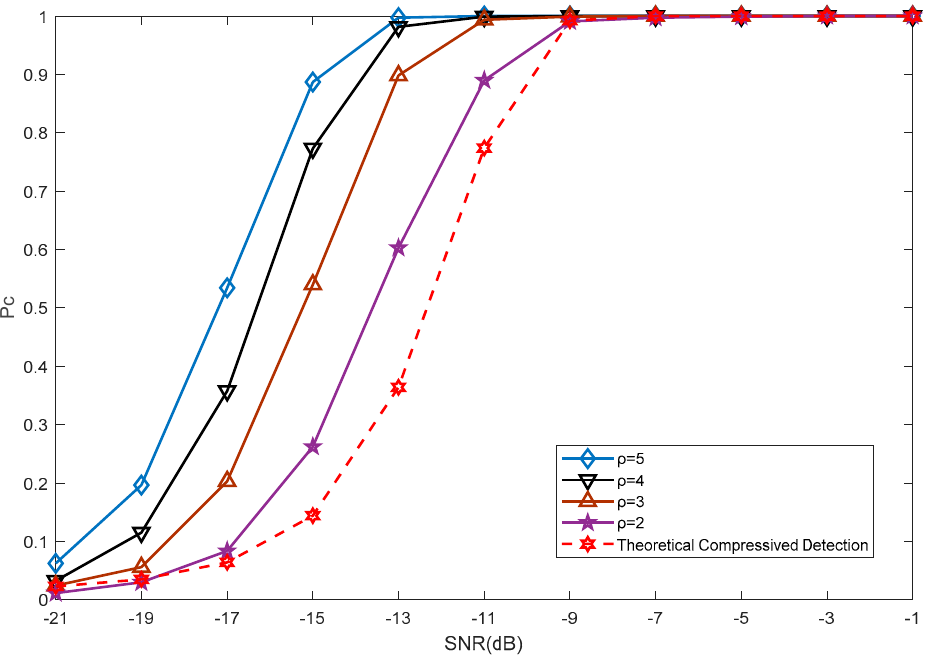
Figure 10. Detection probability of channel estimation.